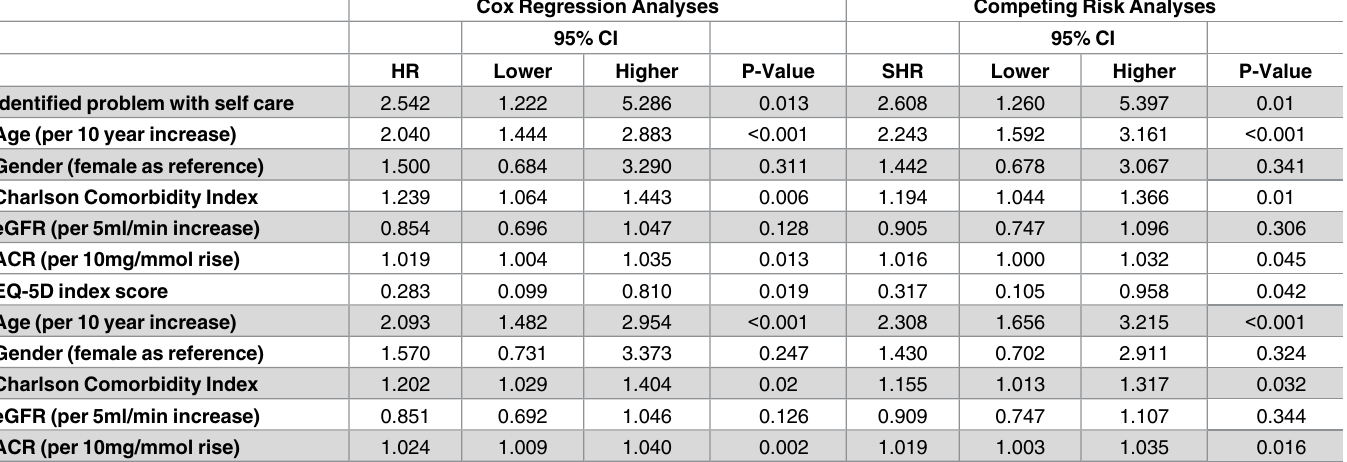
Table 5. Multivariable Survival Analyses(Cox regression and Competing risk) for hazard ratio (HR) and subdistribution hazard ratio (SHR) for